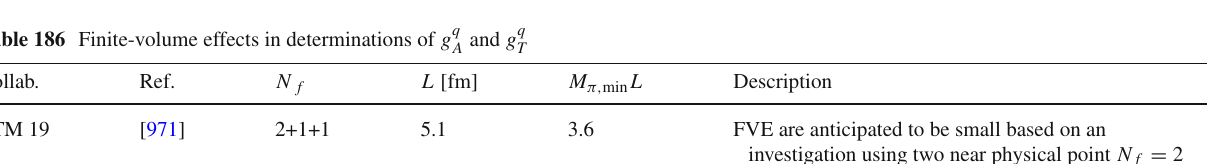
Table 186 Finite-volume effects in determinations of g q